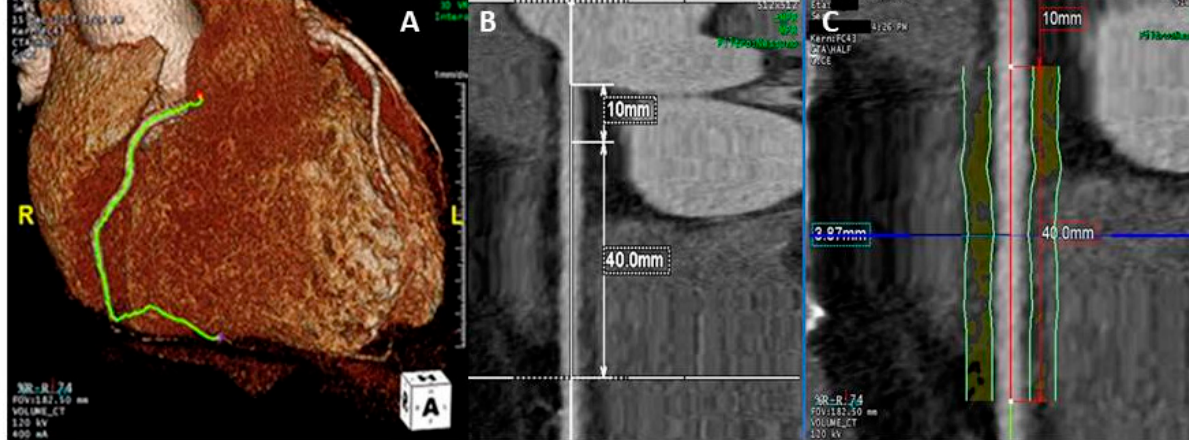
Figure 1. Pericoronary fat attenuation index (pFAI) measurement. The right coronary artery (RCA) is identified on the 3D reconstruction ( A ). The proximal 40 mm segment of the RCA is traced, starting 10 mm from the ostium ( B ). Perivascular fat is defined as the adipose tissue within a radial distance from the outer vessel wall equal to the diameter of the vessel ( C ). Perivascular FAI is then ascertained by quantifying the weighted perivascular fat attenuation based on the attenuation histogram of perivascular fat within the range − 190 HU to − 30 HU (not shown).